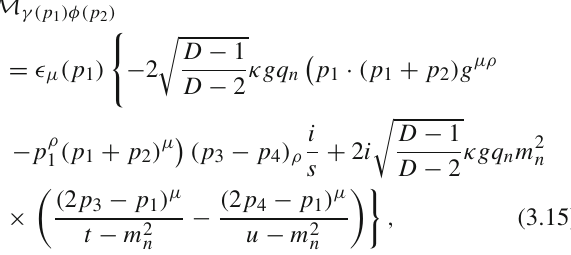
channels (see the third line of